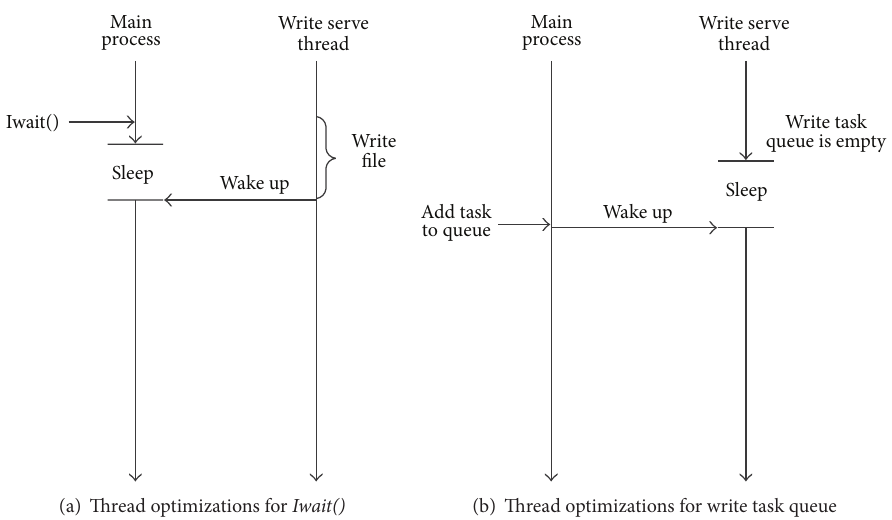
Figure 7: Threading optimizations for AP-IO .